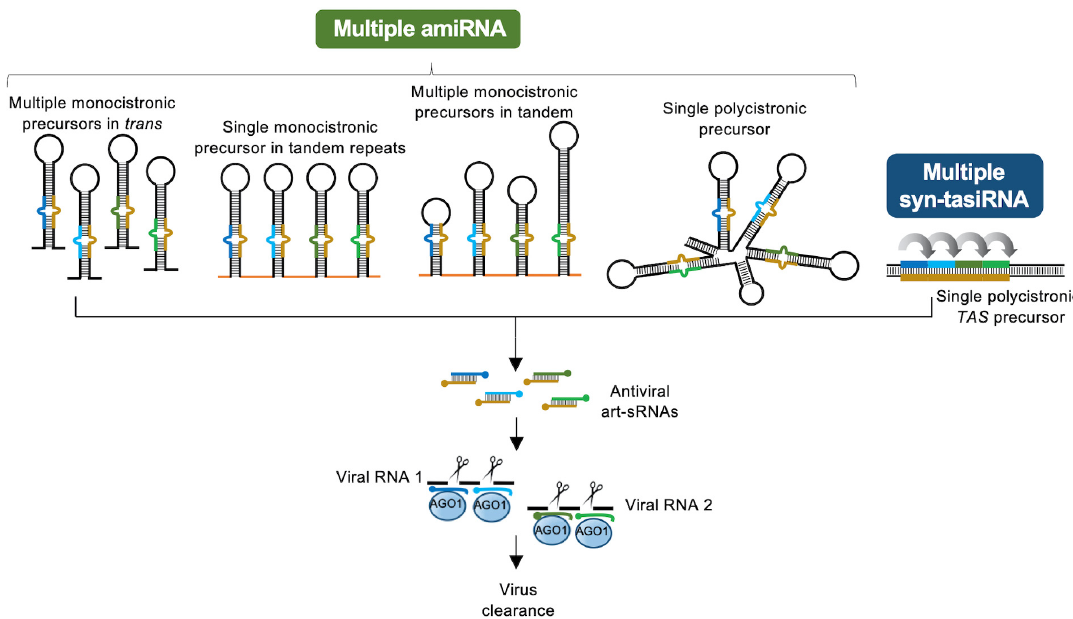
Figure 3. Strategies for the co-expression of multiple art-sRNAs in plants. Multiple amiRNAs are generated from several monocistronic precursors expressed in trans, from a single monocistronic precursor in tandem repeats, from multiple monocistronic precursors in tandem or from a single polycistronic precursor. Multiple syn-tasiRNAs are generated from a single polycistronic TAS precursor. Other details are as in Figure